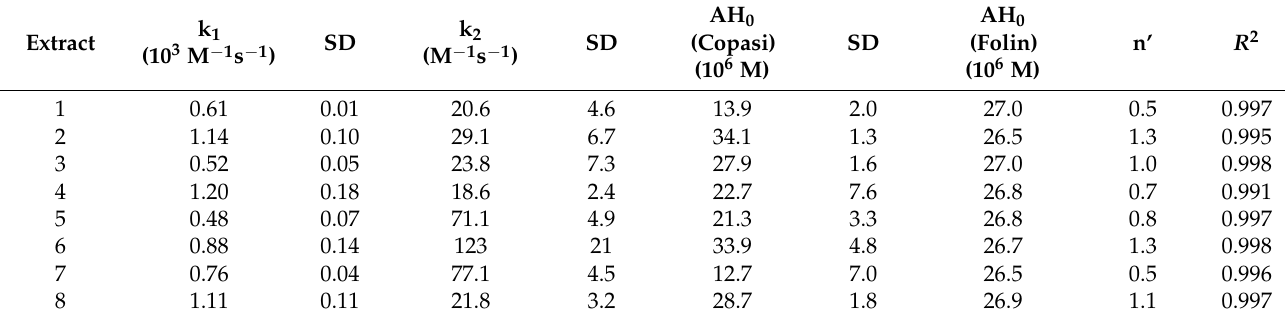
Table 4. The values for k 1 and k 2 are the mean between at least three replicates. AH 0 (Copasi) refers to the mean of the replicates of the M concentration estimated by Copasi, while AH 0 (Folin) refers to the concentration (M GAE) obtained from Folin–Ciocalteu’s method. The apparent stoichiometric factor, n’, is the ratio between the estimated AH 0 and the one measured by Folin–Ciocalteu’s